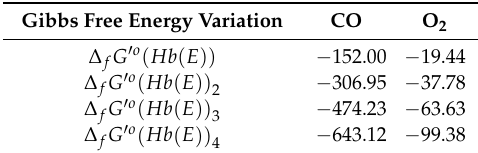
Table 2. Gibbs free energy variation in successive reactions of gases (carbon monoxide and oxygen) with